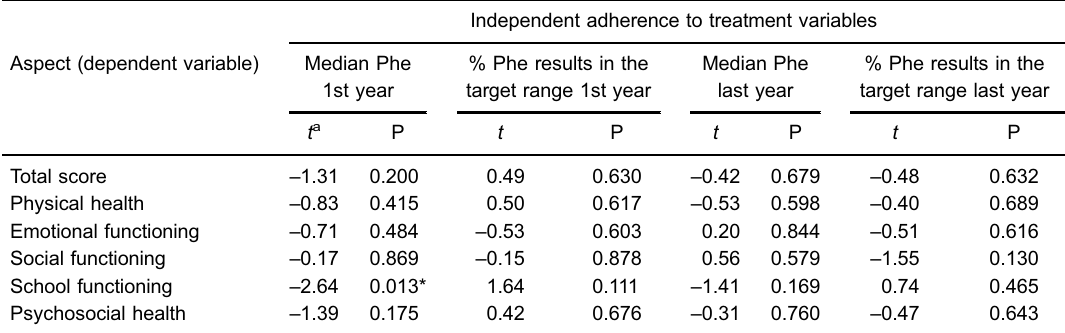
Table 4. Linear regression analysis of the parent proxy-report scores for PedsQL 4.0 generic core scales and adherence to treatment variables of Brazilian early-treated phenylketonuria (PKU) pediatric